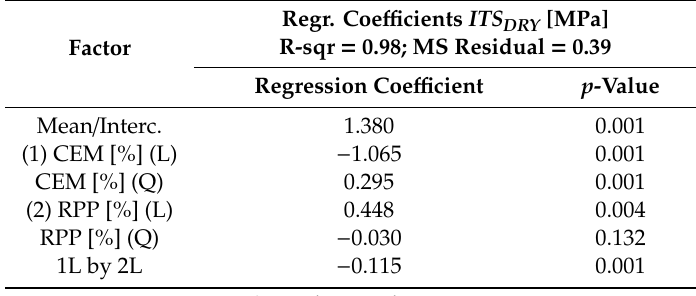
Table 11. Experimental coe ffi cients for indirect tensile strength ITS DRY.